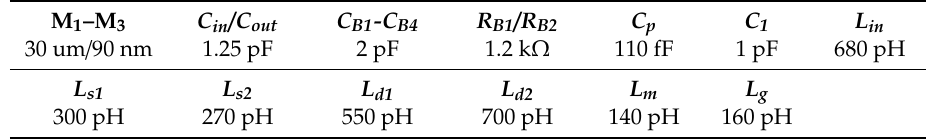
Table 1. Elements values of proposed LNA.